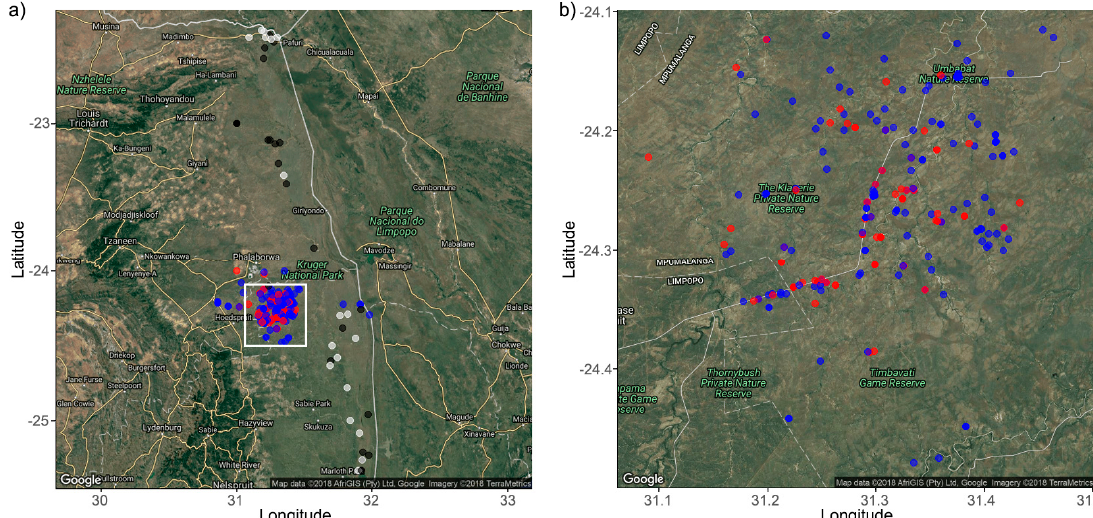
Figure 1. Location of samples used in this study. Blue dots are males from the Associated Private Nature Reserves (APNR); black dots, males from the Kruger National Park (KNP); red dots, females from the APNR; and white dots, females from the KNP. ( a ) Map showing the locations of all samples; ( b ) Enlarged map of the area delimited by the white square in a), where most of the APNR samples were collected.